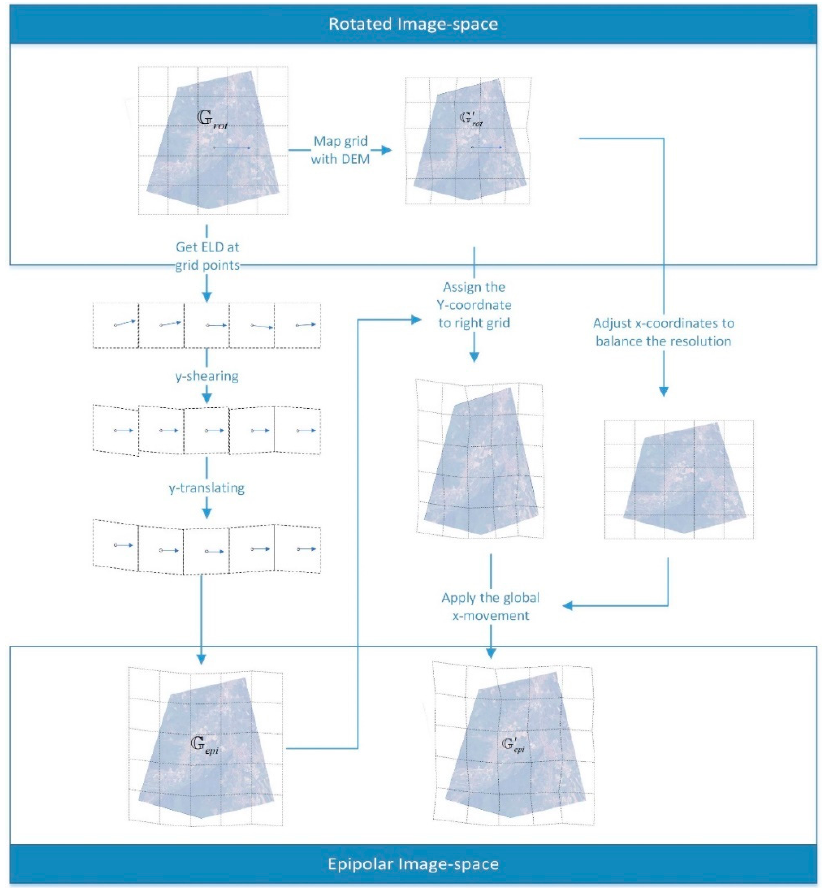
Figure 4. The process of transforming the grid from the rotated image-space to the epipolar image-space in the proposed approach.